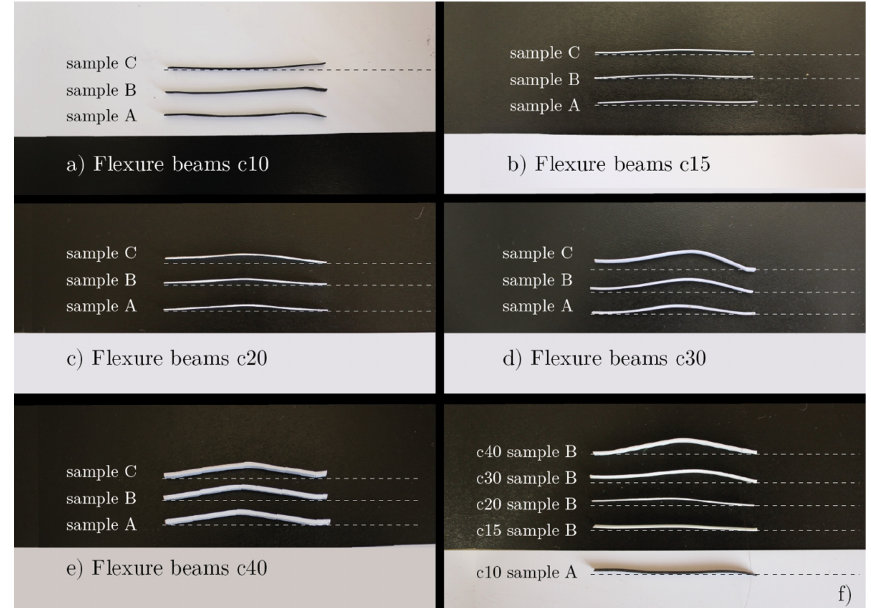
Figure 8. Image of the left side flexure beams after being subjected to compression five times. ( a ) c10 flexure beams (0.25 mm) ( b ) c15 flexure beams (0.38 mm) ( c ) c20 flexure beams (0.50 mm) ( d ) c30 flexure (0.75 mm) ( e ) c40 flexure beams (1.00 mm) ( f ) Compilation of samples of each thickness.